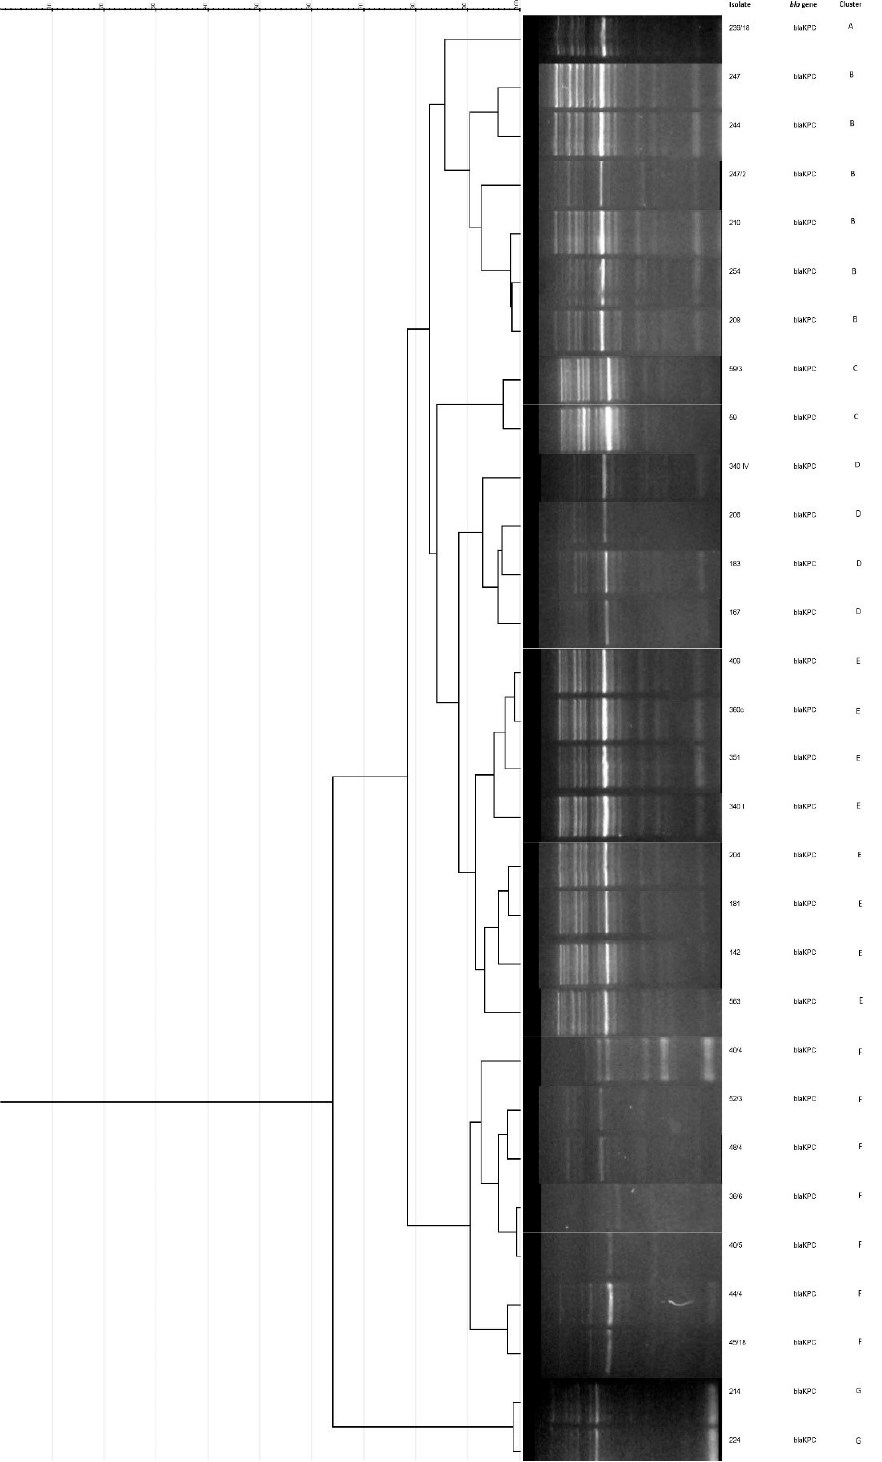
Figure 1. Dendrogram and gel image obtained by ERIC-PCR analysis of bla KPC -positive Klebsiella pneumoniae isolates (N = 30). Seven different clusters (A–G) were generated at the similarity level of 90%. ERIC-PCR, Enterobacterial Repetitive Intergenic Consensus PCR.